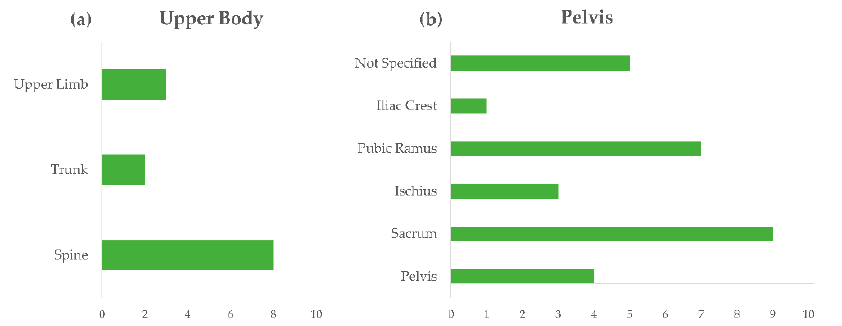
Figure 4. Reviewed articles regarding location of stress fractures in the upper body ( a ) and pelvis ( b